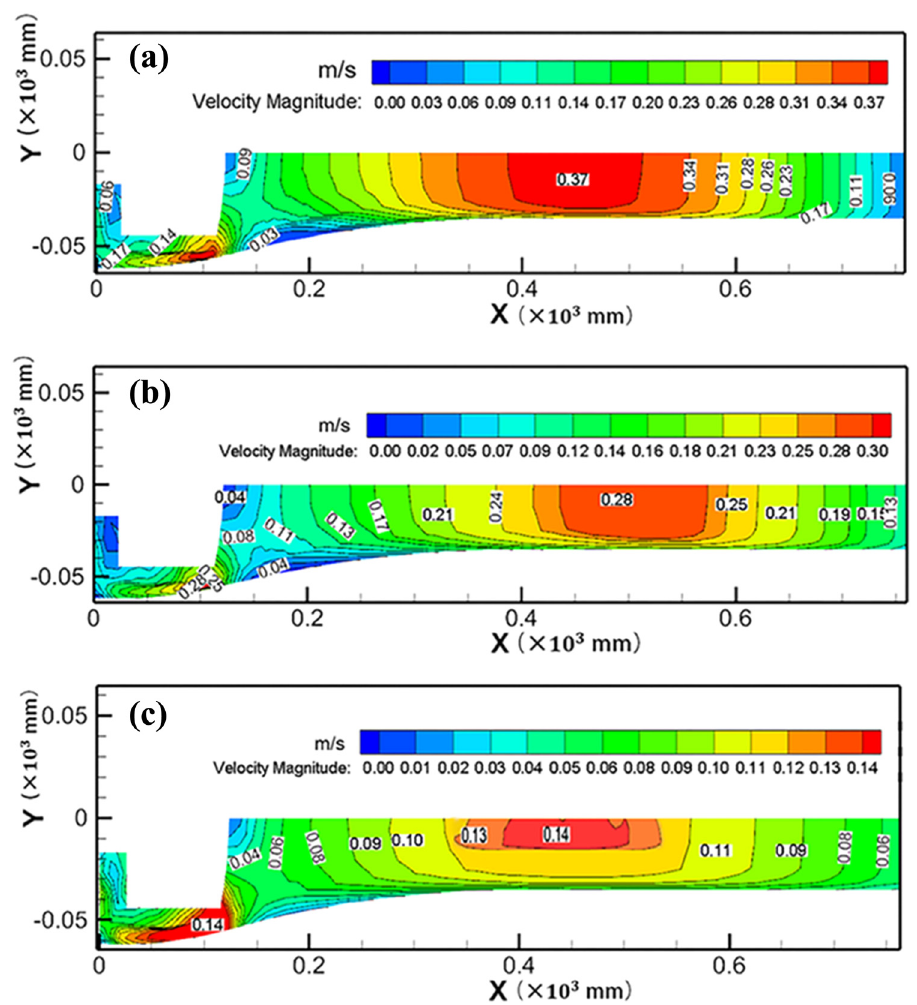
Figure 14: Surface velocity of di ff erent submerged depths at 6 m · min − 1 casting speed: ( a ) 130 mm, ( b ) 160 mm, and ( c ) 190